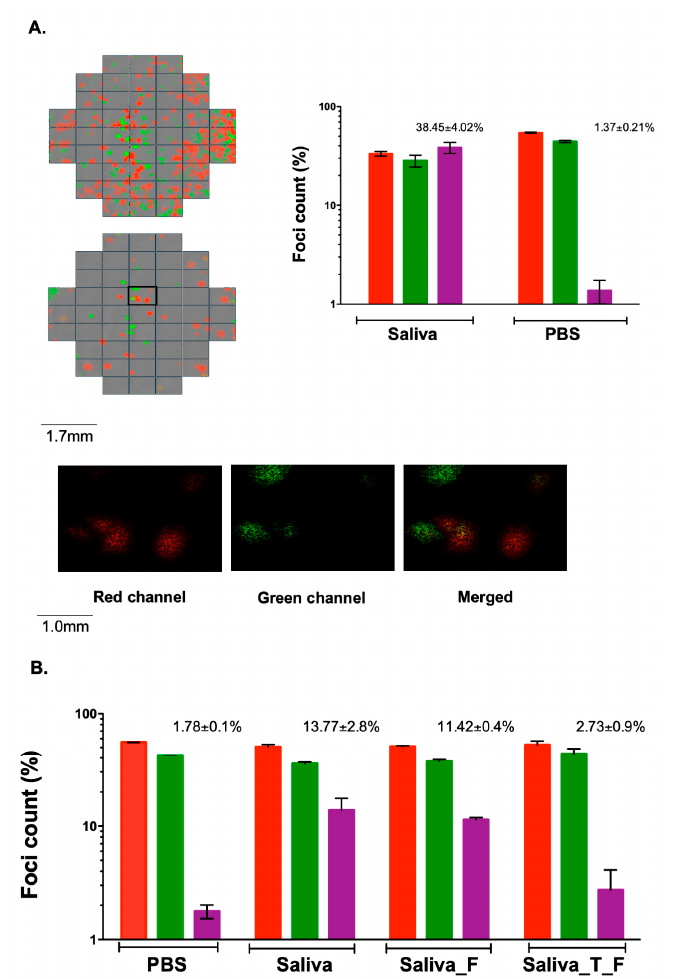
Figure 1. E ff ect of saliva on vesicular stomatitis virus (VSV) aggregation as determined by foci analysis.